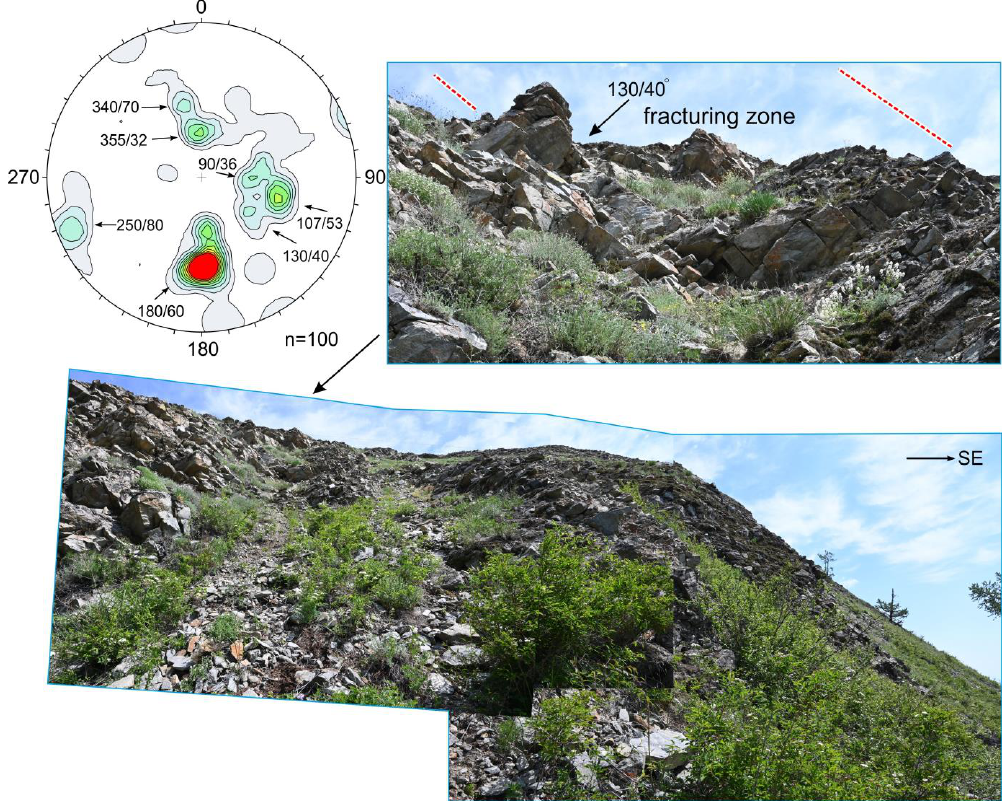
Figure 8. Outcrop of granite rocks in site 3 and fractures diagram (see location in Figure 4, Wulff net upper hemisphere projection; n—number of measurements; counting circle size 1%; intensity isolines are 1, 2, 3 and >; different colors show density concentration from 0 (white) to > 9 (red)).